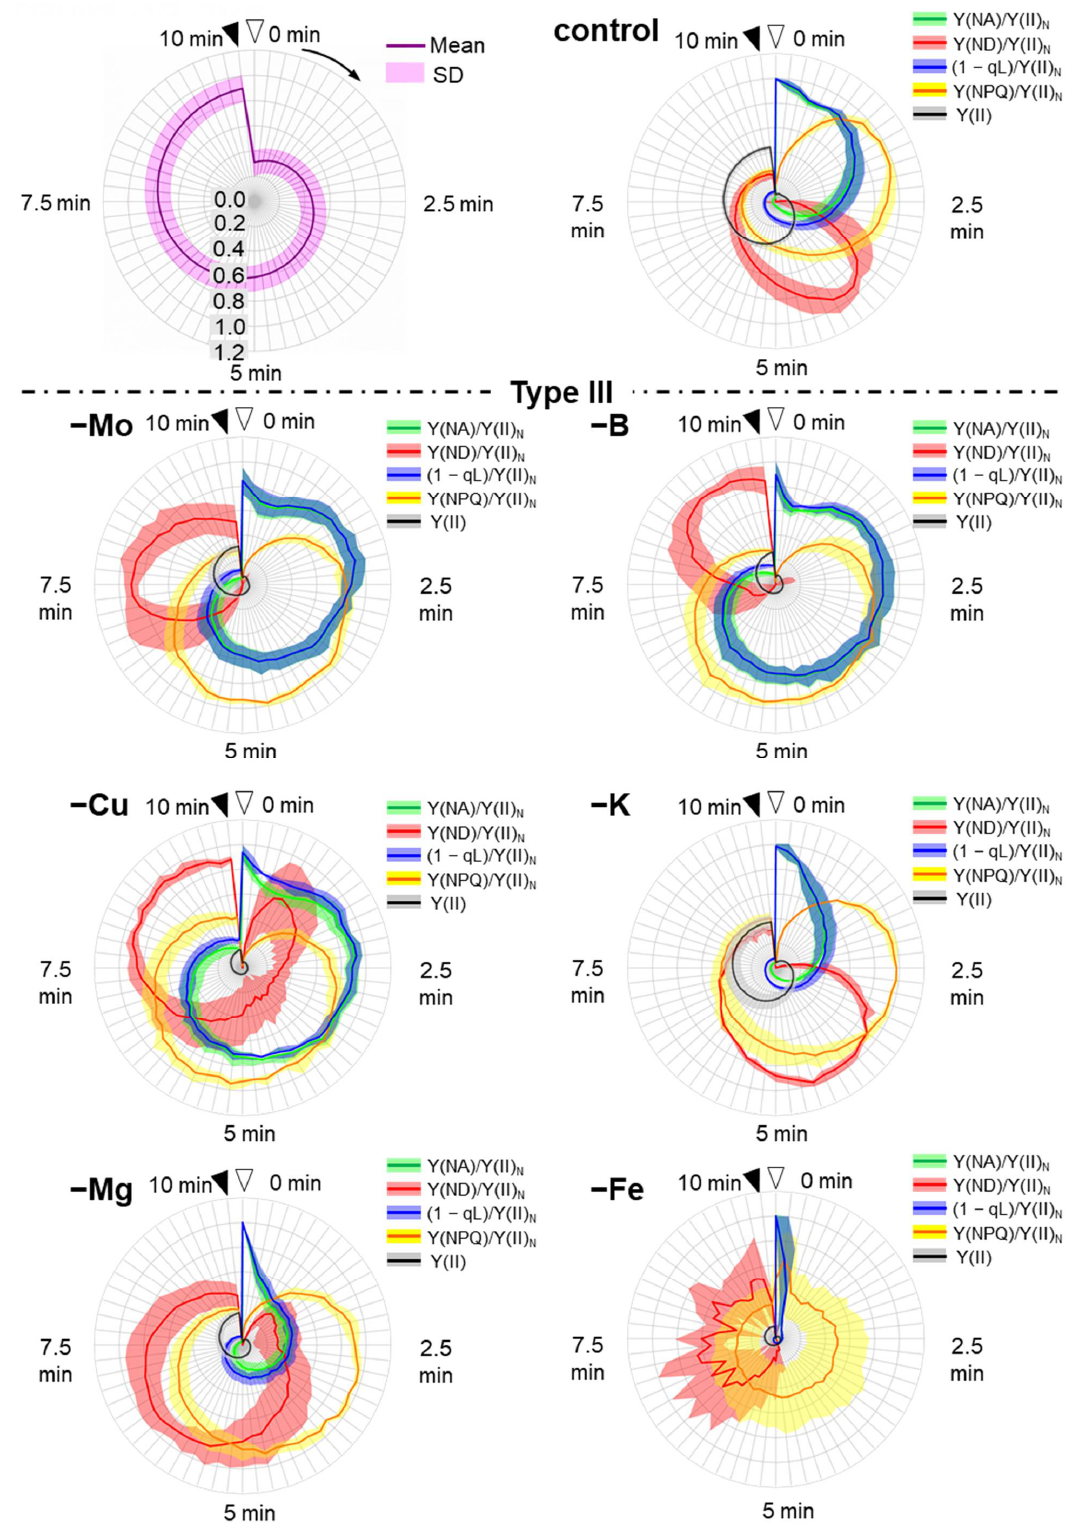
Figure 5. Effects of nutrient-deficiency treatments on the photosynthesis parameters of both photosystems PSI and PSII in the intact leaves of sunflower plants ( Helianthus annuus ). Data were calculated from Figure 3. The parameters [Y(NA)/Y(II) N , green; Y(ND)/Y(II) N , red; (1 − qL)/Y(II) N , blue; Y(NPQ)/Y(II) N , yellow; Y(II), black] during the induction of photosynthesis were plotted against the AL illumination time in the radar-chart plots (Normalized plots). These parameters were normalized by being divided by their maximal values, except for Y(II). Nutrient-deficiency treatments were as follows: Type-I: nitrogen deficiency (–N); phosphate deficiency (–P). Type-II: calcium deficiency (–Ca); zinc deficiency (–Zn); sulfur deficiency (–S); manganese